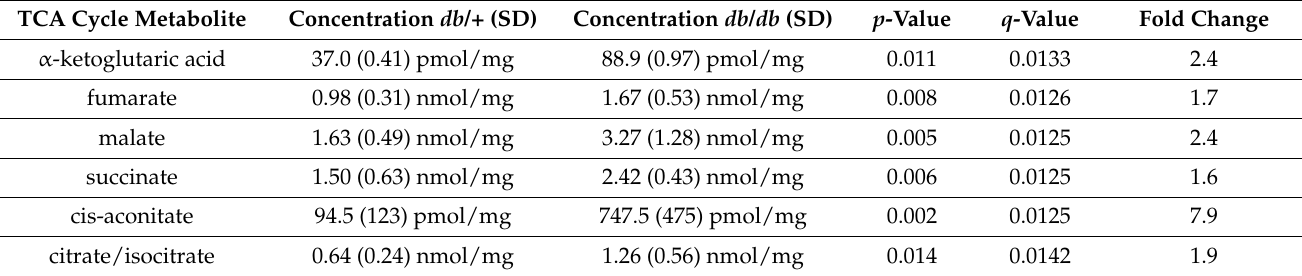
Table 1. Concentration of TCA cycle metabolites from db / + vs. db / db kidney cortex. Concentration of each metabolite was normalized to tissue protein. Q-value was calculated with Benjamini, Krieger, and Yekutieli procedure.